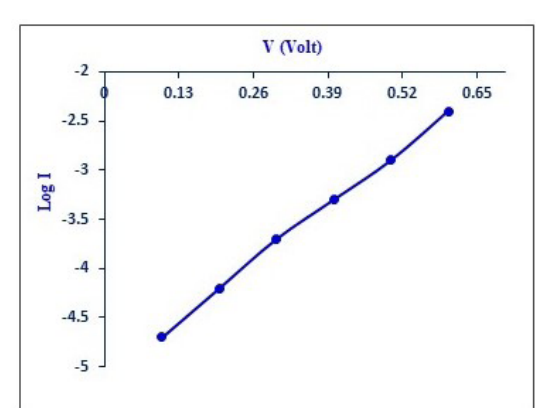
Figure 4. A Schematic diagram of photovoltaic solar cell electrode.